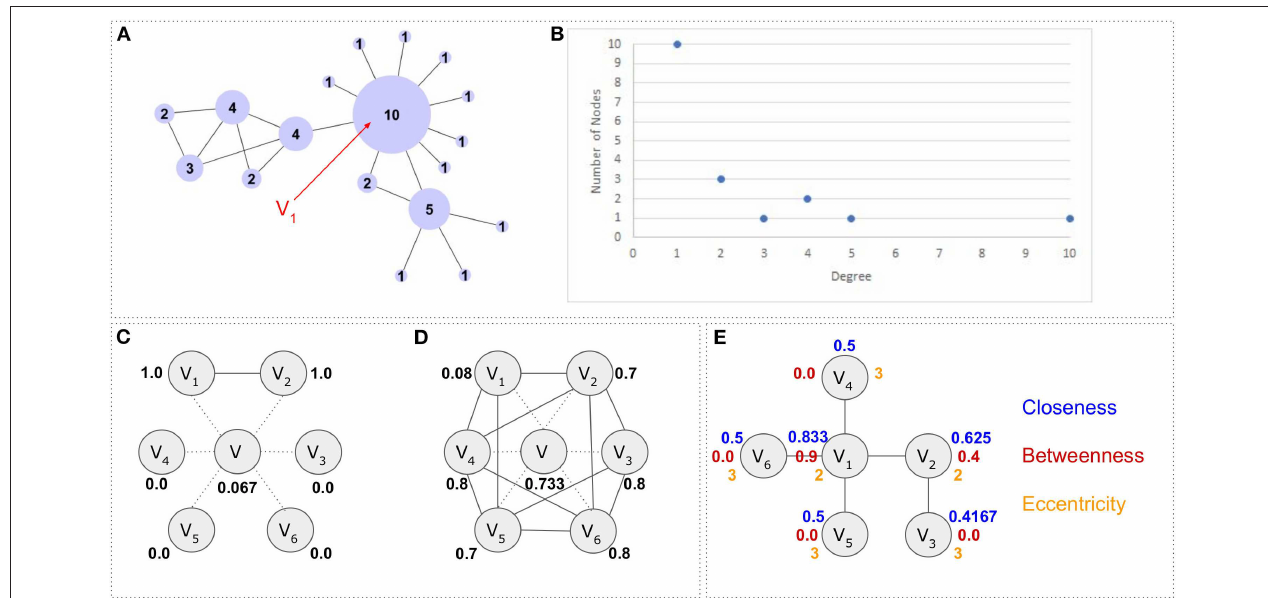
FIGURE 3 | Network properties and topological features. (A) A network G = ( V , E ) consisting of V = 18 nodes and E = 21 edges. Each node’s size has been = 2.333. Network adjusted according to its degree. Vertex V 1 for example has 10 neighbors, thus degree d ( V 1 ) = 10. The average degree for the whole network is 42 18 has been visualized with Cytoscape. (B) A scatterplot histogram showing the degree distribution. The Y axis holds the values about how many nodes have certain degree (values in X axis). (C) Clustering coefficient. Node V has 6 neighbors { V 1 V 2 , V 3 , V 4 , V 5 , V 6 }. The maximum number of edges between these neighbors are 6(6 − 1) = 15 but only two neighbors (V 1 and V 2 ) are connected to each other thus making the clustering coefficient for node V equal to 1 = 0.066. (D) Similarly, the 2 15 neighbors of node V are connected with 11 edges between each other (E = {{V 1 ,V 2 }, {V 1 ,V 5 }, {V 1 ,V 4 }, {V 2 ,V 3 }, {V 2 ,V 6 }, {V 2 ,V 4 }, {V 3 ,V 6 }, {V 3 ,V 5 }, {V 4 ,V 6 }, {V 4 ,V 5 }, = 0.733. Notably dotted lines represent the direct connections of node V , whereas the solid lines {V 5 ,V 6 }}), the clustering coefficient for this node will be C V = 11 15 represent the connections between the first neighbors of node V . (E) The closeness centrality in blue, the betweenness centrality in red and the eccentricity centrality in orange. The graph consists of 6 nodes and 5 edges. Closeness centrality calculation example: Node V 1 accesses nodes V 2 , V 4 , V 5 , V 6 with step 1 and node V 3 = 5 = 0.833. Betweenness centrality calculation example: Since all nodes are accessible with step 2. Therefore, its closeness centrality is calculated as 5 4 × 1 + 2 × 1 6 through any other node, there are N ( N − 1) = 6 × 5 = 30 shortest paths but only 12 of them pass through node V 2 . These are { V 3 , V 2 } , { V 3 , V 2 , V 1 } , { V 3 , V 2 , V 1 , V 4 }